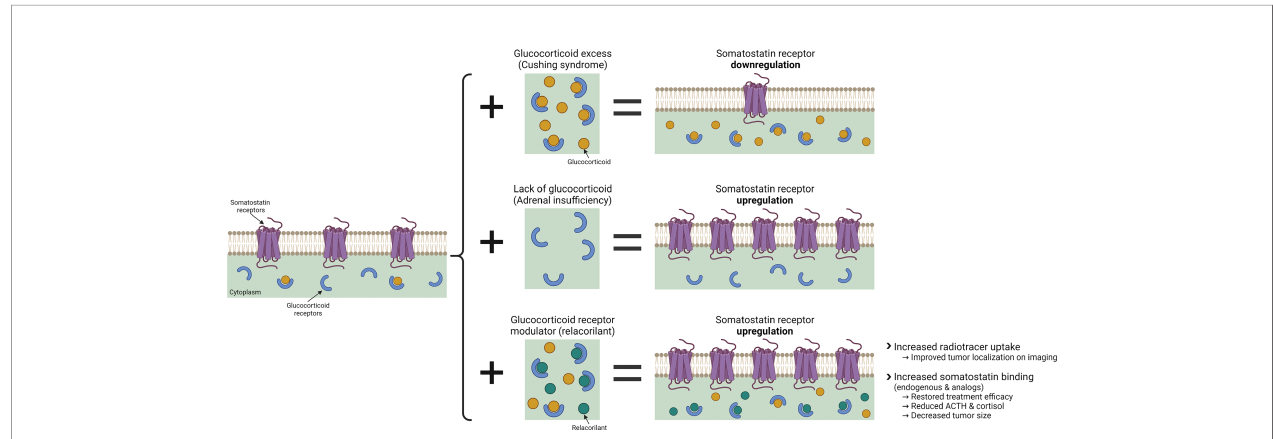
FIGURE 1 | The effects of glucocorticoid and glucocorticoid modulation with relacorilant on SSTR regulation. Created with